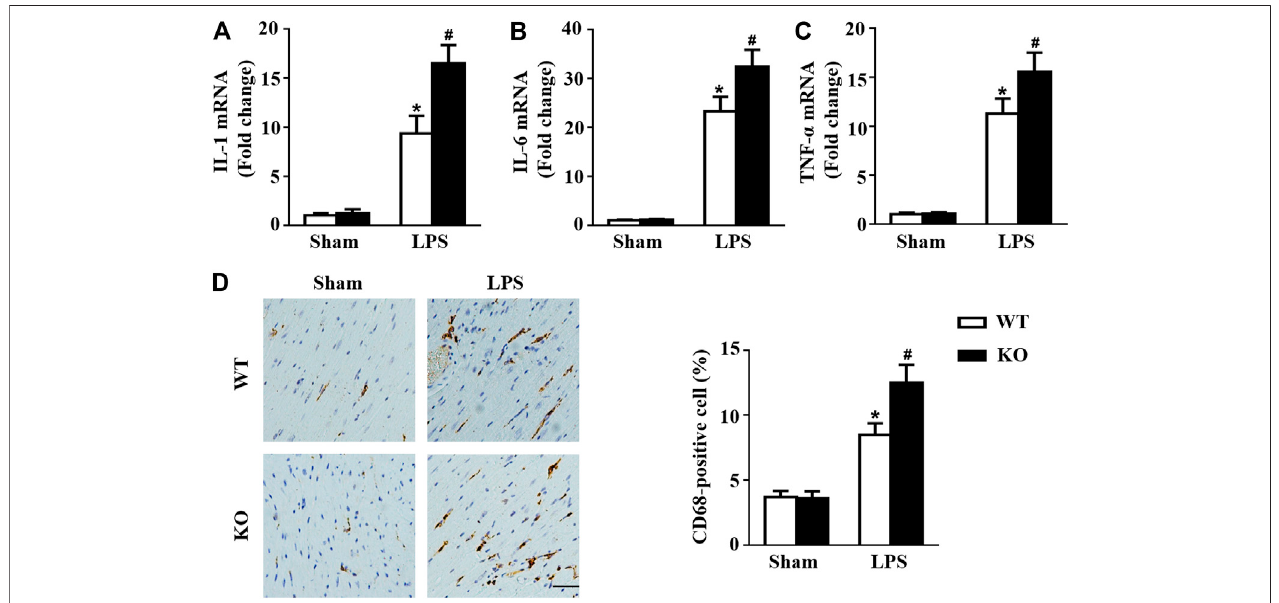
FIGURE 4 | Il12a deletion mediates macrophage polarization in the heart. (A – C) RT-PCR analysis of IL-1 β , IL-6 and TNF- α mRNA expression in each group (n (cid:1) 4). (D) ImmunohistochemicalanalysisofCD68inheartsections(n (cid:1) 4;scalebar,50 μ m).* p < 0.05comparedwiththesham+WTgroup; # p < 0.05comparedwiththeLPS+WTgroup.